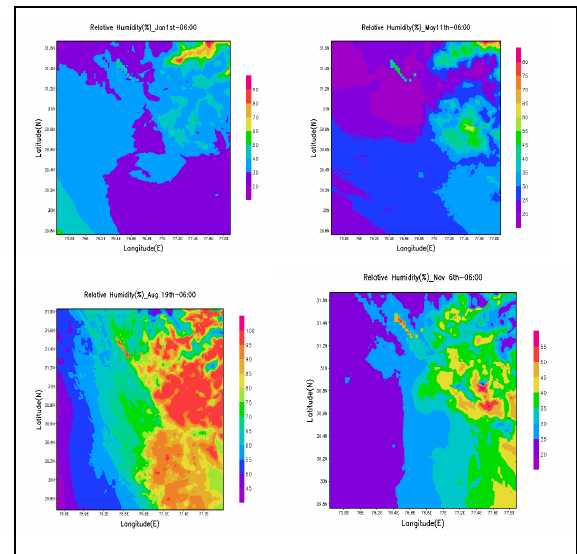
Figure 4. Spatial distribution of Relative Humidity over d02 on 1st 11th different seasons Jan 11:30 IST, May 11:30 IST, Aug 19th 6th 11:30 IST and Nov 11:30 IST with